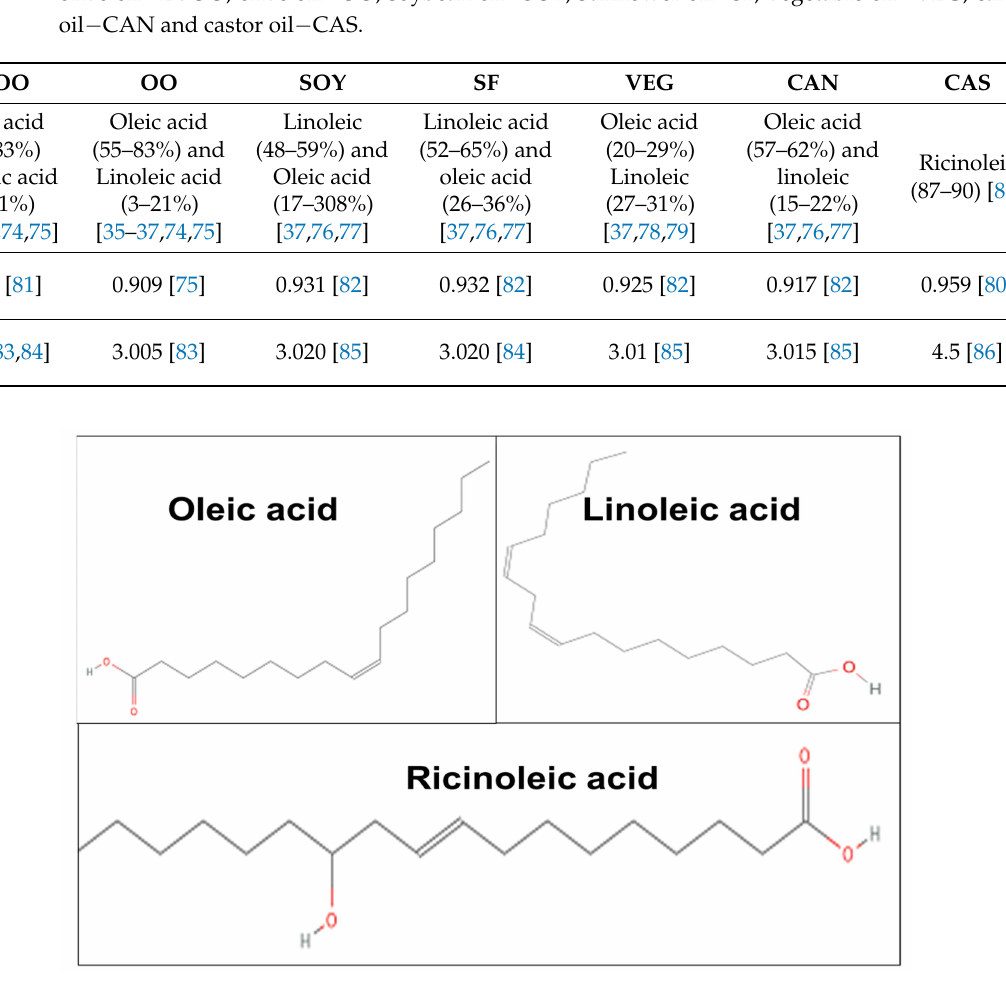
Figure 6. Chemical structure of different fatty